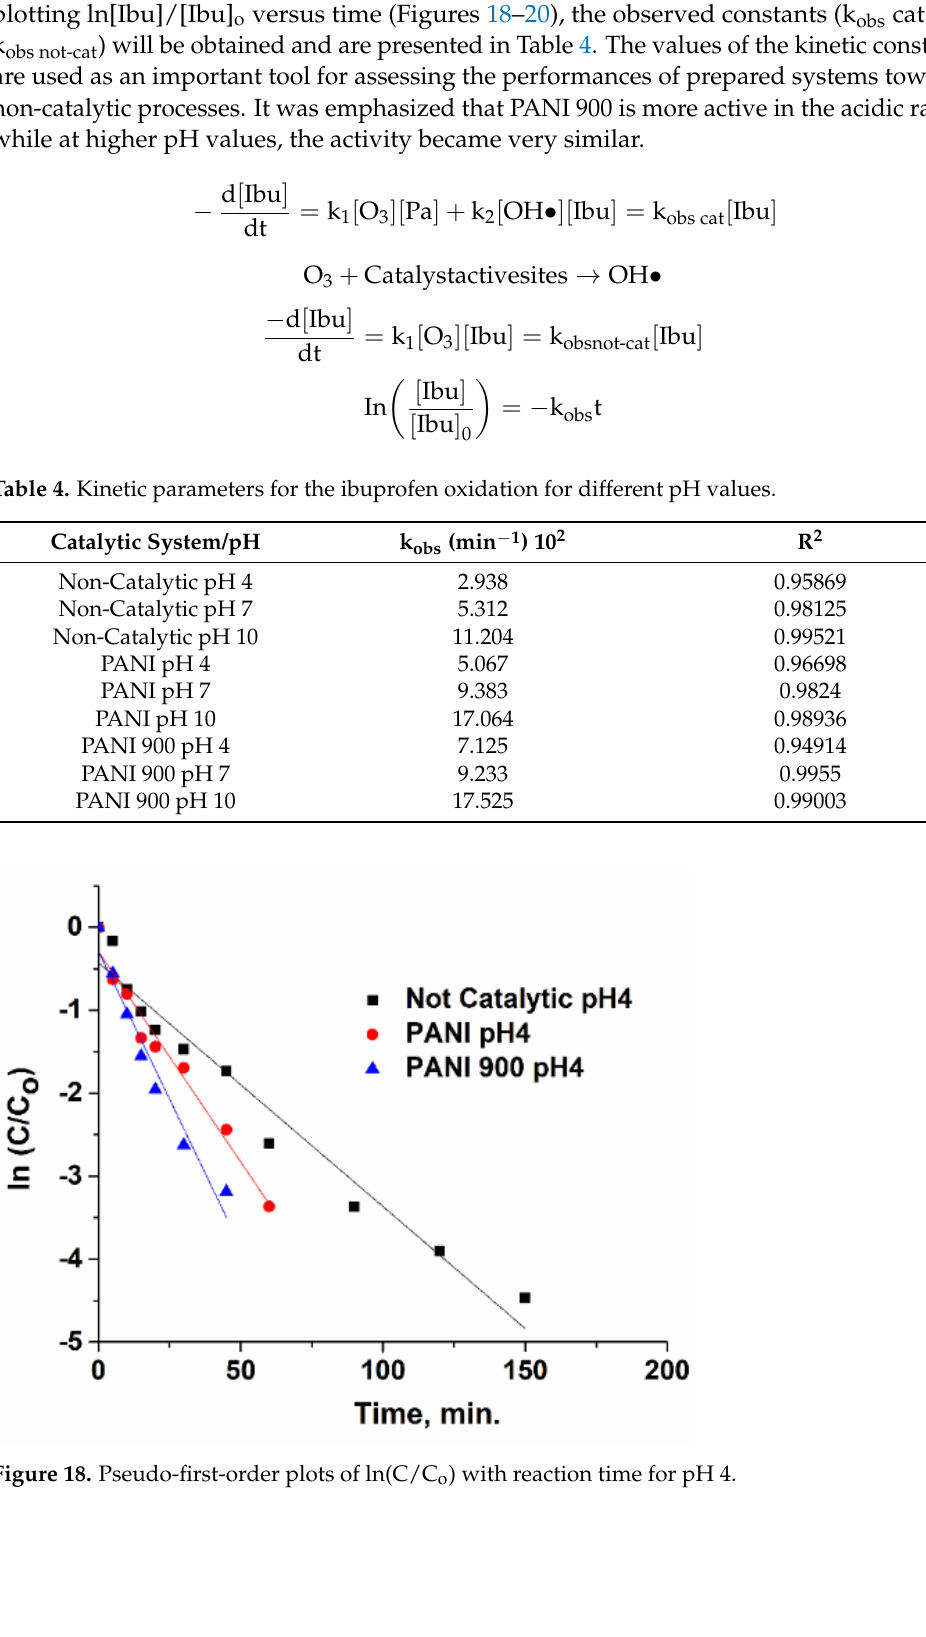
Figure 19. Pseudo – first – order plots of ln(C/C o ) with reaction time for pH 7. Figure 20. Pseudo – first – order plots of ln(C/C o ) with reaction time for pH 10.